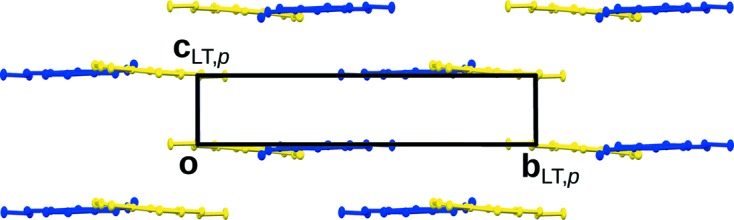
A slab of a and b molecules viewed down [100]. Molecule colours are as in Fig. 6 ▸.